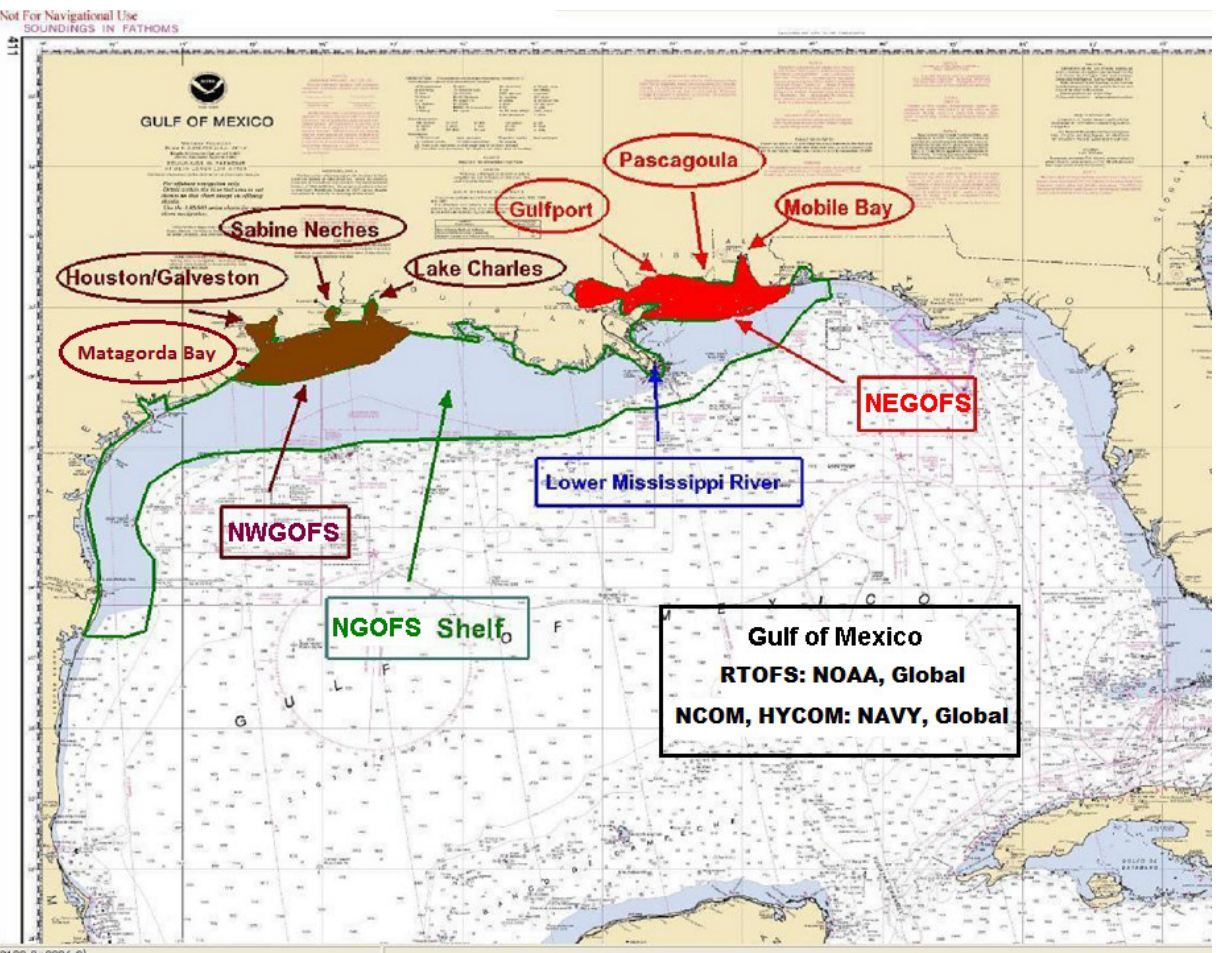
Figure 1. Schematic NOS PORTS ® locations and nested Northern Gulf of Mexico model